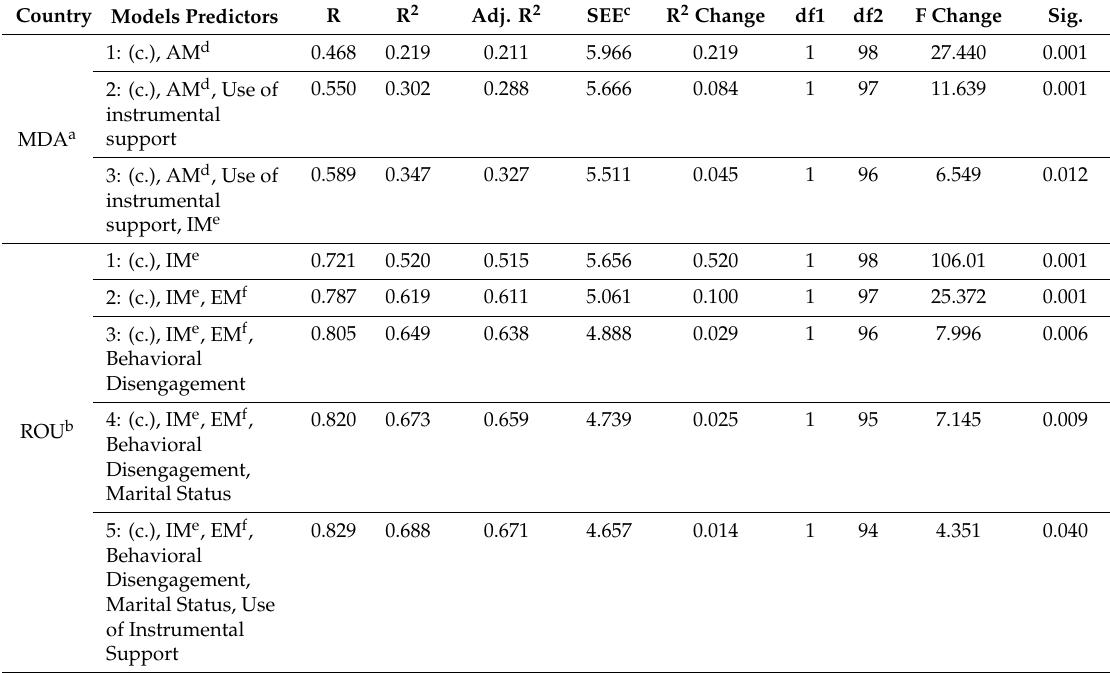
Table 4. Hierarchical linear regression models of cynicism in Moldova and